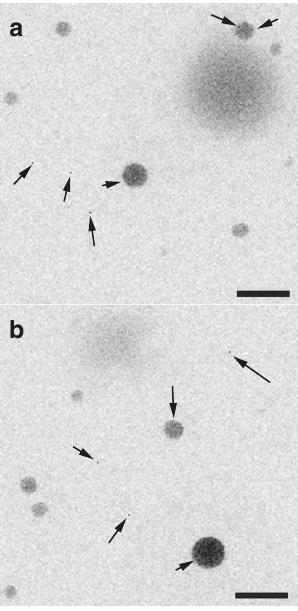
Fig. 7 TEM images of calcium oxalate nanoclusters. a , b Citrate-stabilized CaC 2 O 4 nanoclusters in dry state, formed at 10,000s, showing isolated tiny species (average size 1.9 ± 0.2 nm, indicated by black arrows ) scattered all over the image area as well as forming part of bigger nanometer-size aggregates. Scale bars : 50